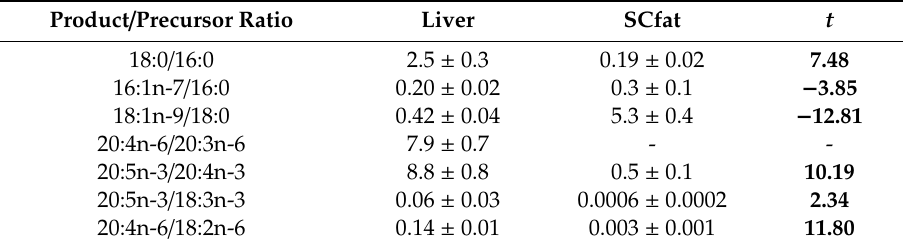
Table 5. Calculated desaturase and elongase activity